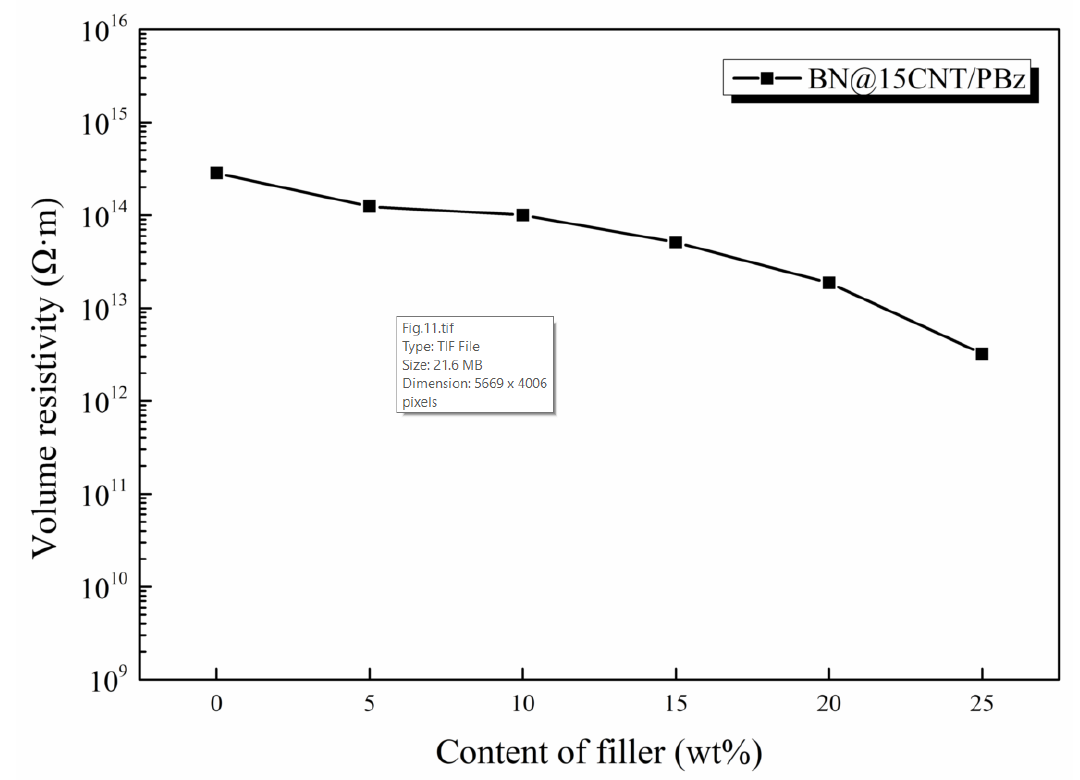
Figure 11. Volume resistivity of BN@15CNT / PBz composites as a function of filler content.